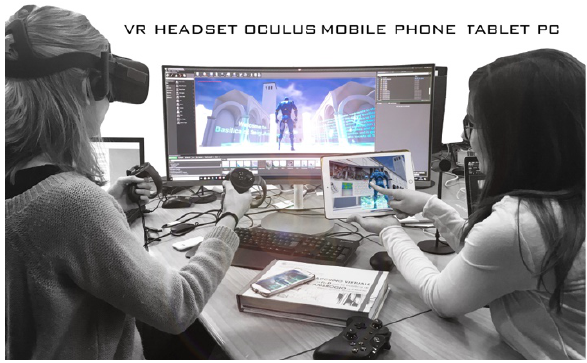
Figure 13. Xr project is developed for the different type of